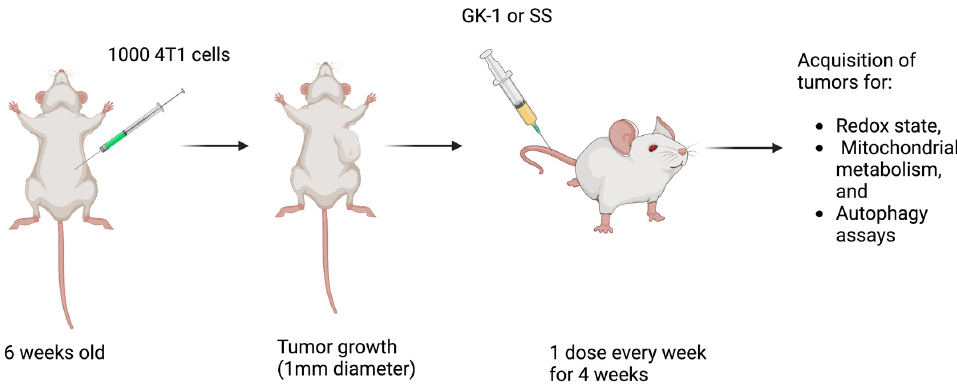
Figure 1. Experimental design. Female BALB/c mice were divided into two groups: (1) Control group (treated with saline solution, SS) and (2) GK-1 group, treated with GK-1. SS or GK-1 was administered each week for 4 weeks. At the end of 4 weeks, mice were anesthetized and sacrificed to remove the tumor for analysis. The number of mice for each experiment was 5 per group (n = 5). The figure was created with BioRender.com.